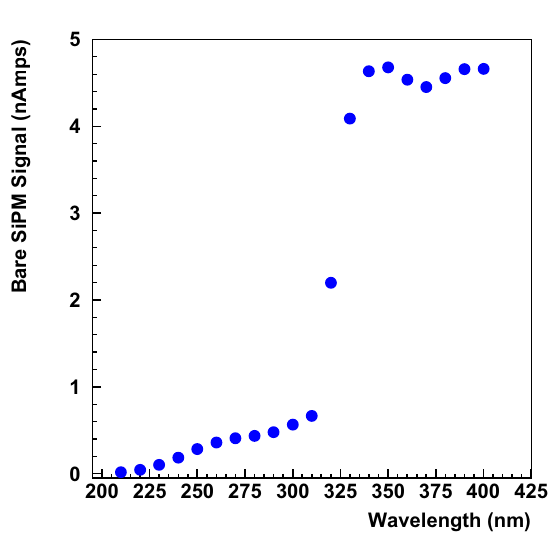
Figure 4. Baseline response of 1 mm × 1 mm (red dot), and 3 mm × 3 mm (blue square) MPPCs in the wavelength range from 195 to 400 nm.